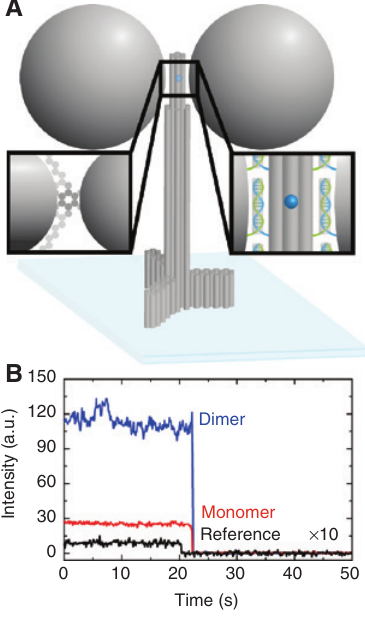
Figure 1: Experimental description. (A) Sketch of the OA consisting of two 80-nm-diameter Ag NPs self-assembled onto a 3D DNA origami structure. In the 12-nm gap between the NPs, a single fluorophore Alexa488 is positioned. (B) Fluorescence transients extracted from samples A (reference), B (monomers), and C (monomers and